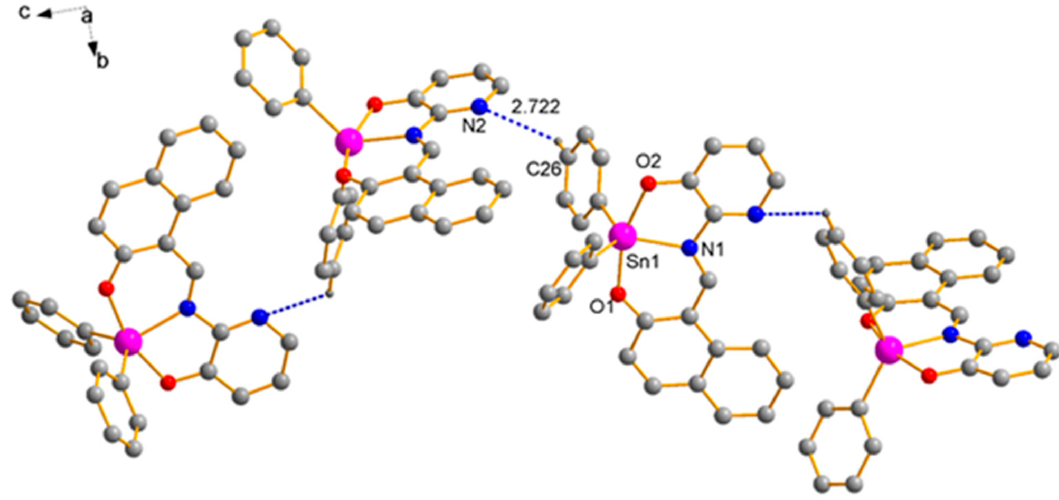
Figure 2. One-dimensional polymeric chain formed by C-H ··· N (blue dots) interactions in 1c (sym- metry code: i 3/4-x,-1/4+y,-1/4+z).